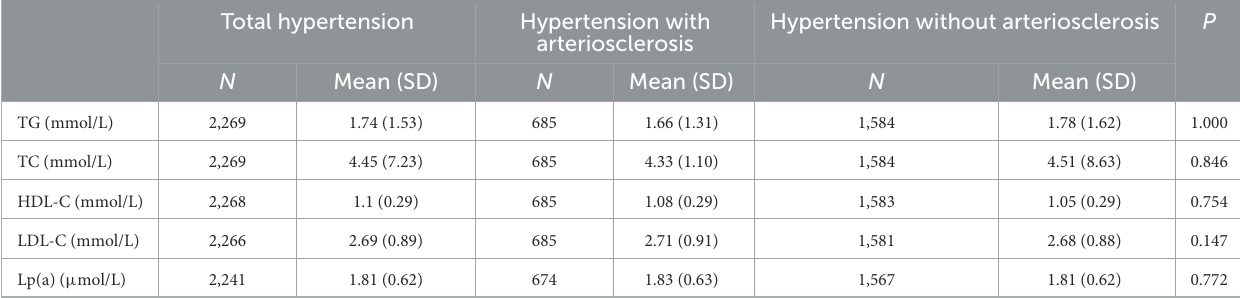
TABLE 1 General lipid profile of the study population. Total hypertension Hypertension with